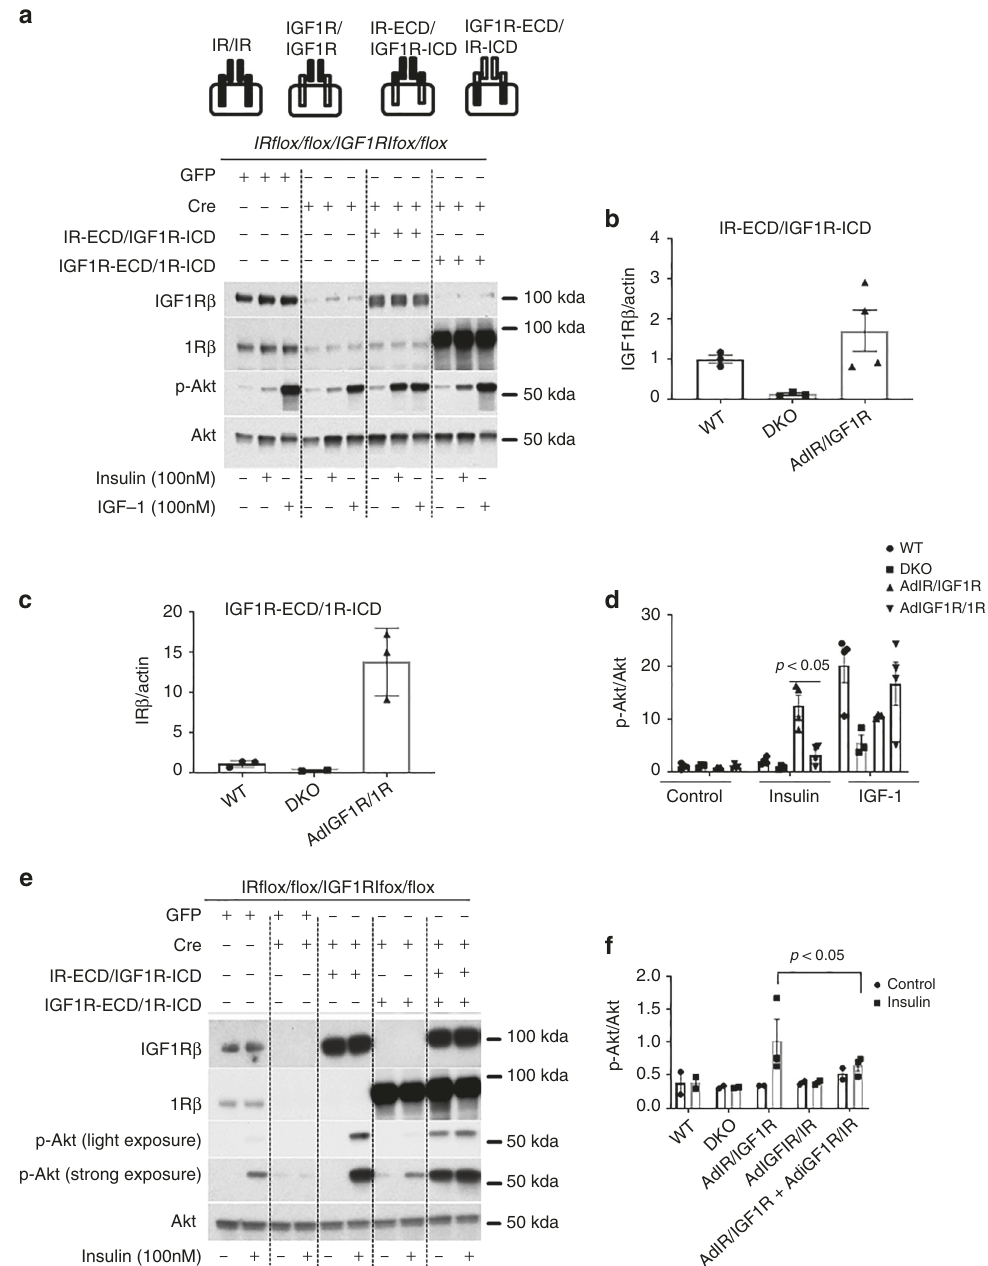
Fig. 5 Insulin and IGF-1 action on chimeric IR/IGF1R receptors. VSMCs were cultured from aortas of mice which had both IR fl ox/ fl ox and IGF1R fl ox/ fl ox alleles. Then IR fl ox/ fl ox IGF1R fl ox/ fl ox VSMCs were infected with AdCre to knockdown both IR and IGF1R. The IR and IGF1R double knockdown VSMCs were further infected with AdIR-ECD/IGF1R-ICD or AdIGF1R-ECD/IR-ICD or both to overexpress chimeric IR-ECD/IGF1R-ICD or IGF1R-ECD/IR-ICD receptors. a , e indicate representative western blotting images. b – d , f show summarized quanti fi cation data ( b , n = 3 for WT and DKO, n = 4 for AdIR/IGF1R; c , n = 3 for each group; d , n = 4 for WT, AdIR/IGF1R, and AdIGF1R/IR, n = 3 for DKO; f , n = 3 for each group). The data are mean ± SEM. Two-way ANOVA with a post hoc test. Source data are provided as a Source Data fi